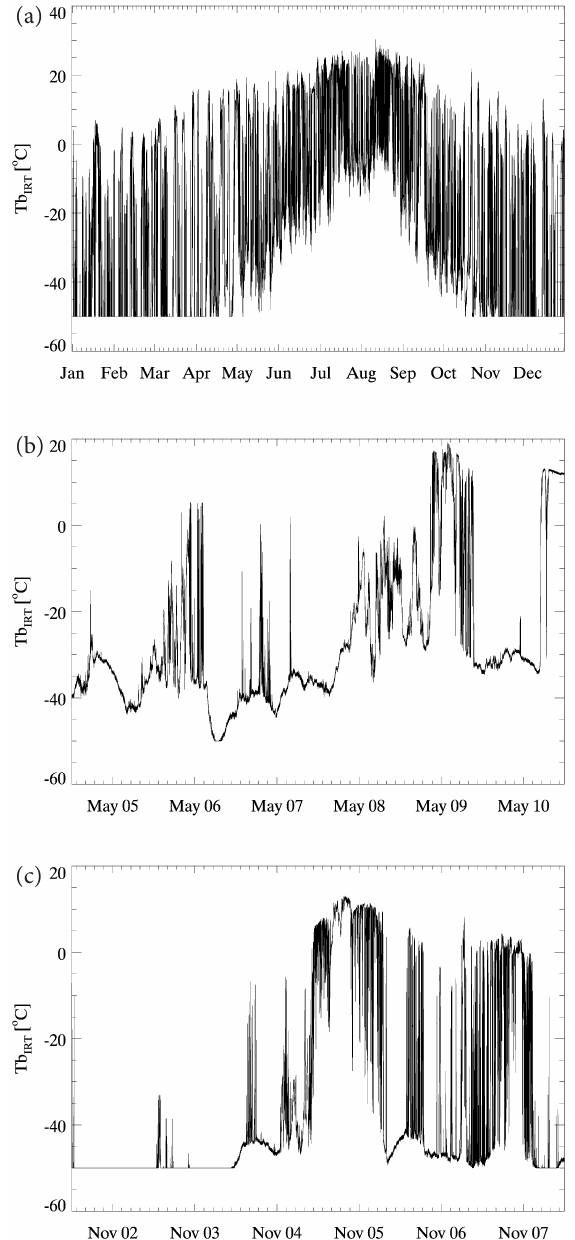
Figure 2. Time series of the measured brightness temperature of infrared radiometer (Tb IRT ) for a period of one year (a) , five days during the summer (b) , and winter time periods (c) obtained at the Changwon Weather Station. The current version of IRT is set to have a lower limit of detection at − 50 ◦ C, which is evident from the data obtained during the winter